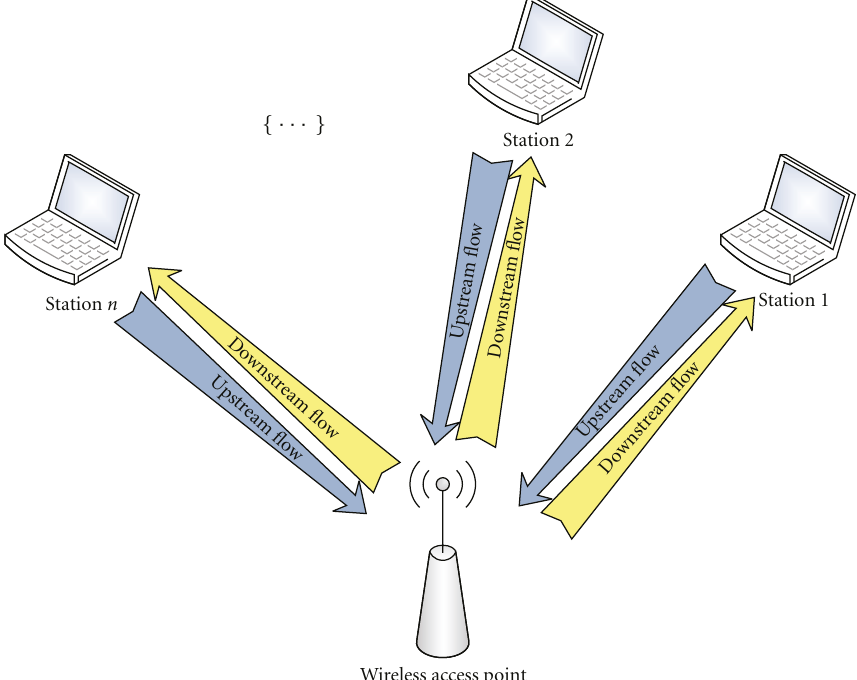
Figure 1: Scenario of AP